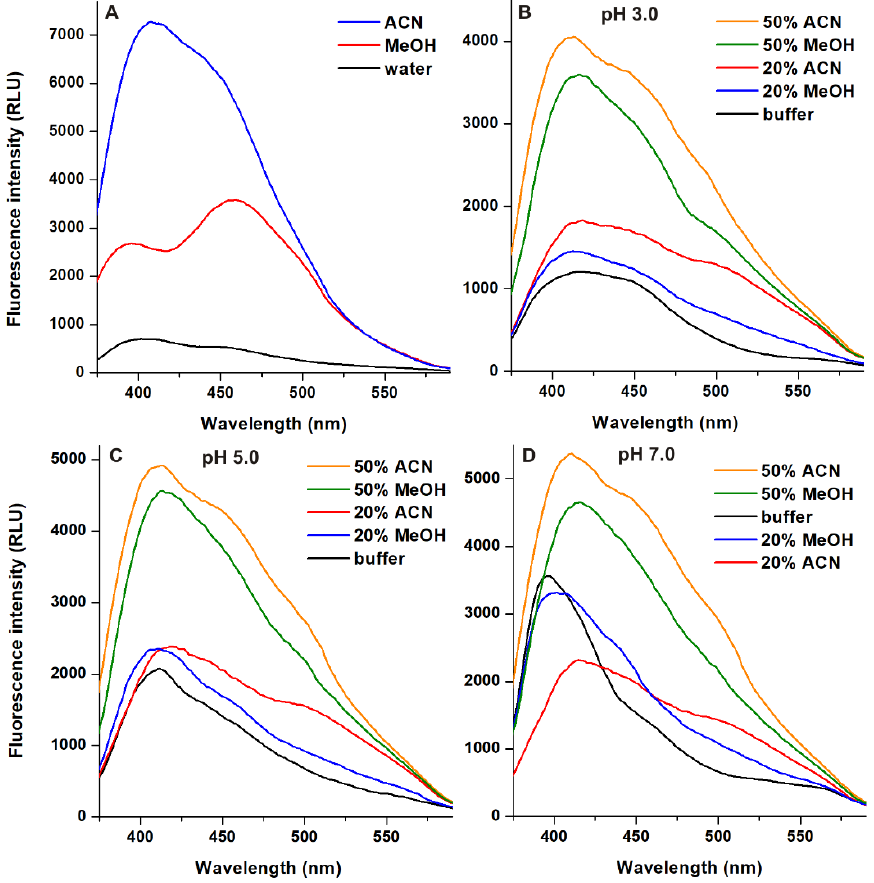
Figure 3. Emission spectra of AOH (25 µ M) in pure solvents (( A ); ex slit: 5 nm, em slit: 10 nm) and in the presence of 20 or 50 v/v % organic solvents in sodium phosphate (( B ); 50 mM, pH 3.0; ex and em slits: 10 nm), sodium acetate (( C ); 50 mM, pH 5.0; ex and em slits: 10 nm), and Tris-HCl (( D ); 50 mM, pH 7.0; ex and em slits: 10 nm) buffers ( λ ex = 345 nm; ACN, acetonitrile; MeOH, methanol; RLU, relative light unit).